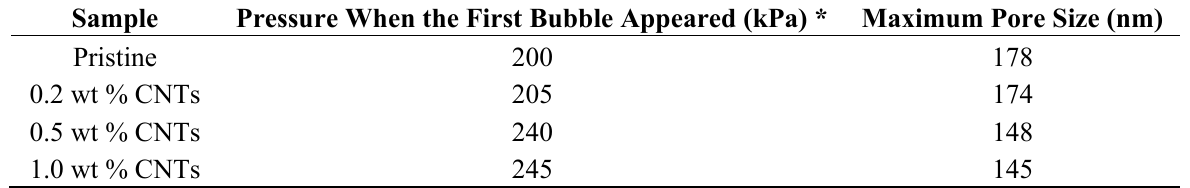
Table 1. Maximum pore size of alumina/polymer membranes with different CNTs loadings. Sample Pressure When the First Bubble Appeared (kPa) * Maximum Pore Size (nm) Pristine